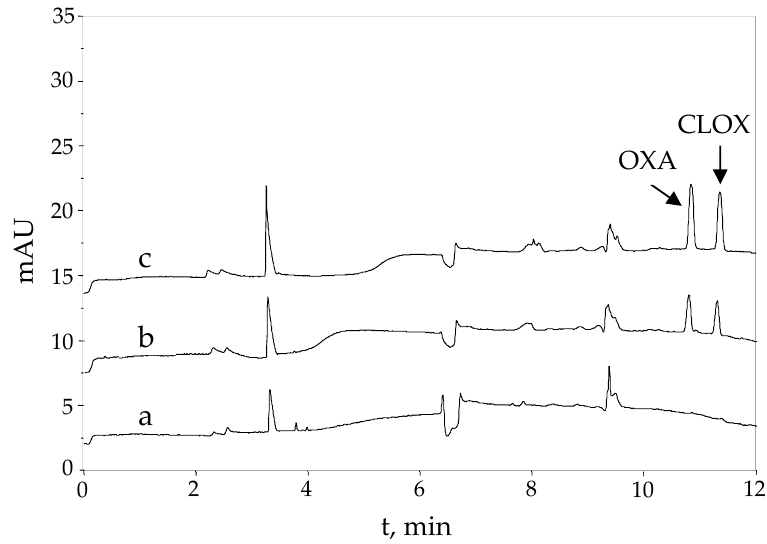
Table 3. Determination of the two β -lactams and their recoveries from river water samples. Added Analyte (ng/mL)